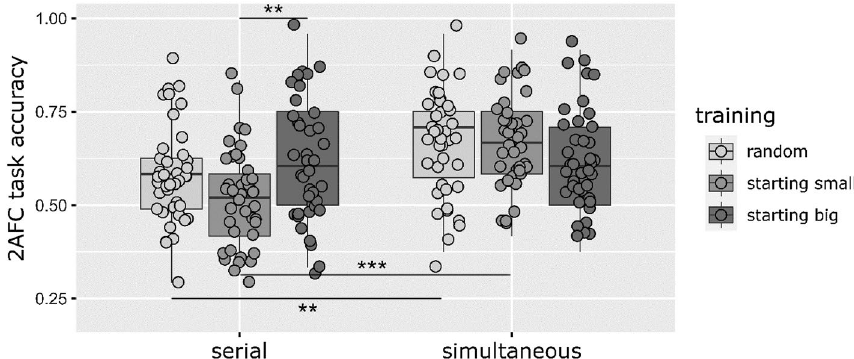
Figure 6. 2AFC accuracy in the Presentation*Training Type interaction in the case of visual stimuli. Dots represent the mean accuracies of individual participants in a given group (a small amount of jitter was added to increase visibility). Lines in boxes represent group medians, box lengths illustrate the group interquartile range, and whiskers show minimum and maximum values. Outliers are participant data which are outside the 1.5 interquartile range beyond the first and third quartiles. *: p < 0.05, **: p < 0.01, ***: p < 0.001. Serial starting small performance was lower than serial starting big performance, and simultaneous starting small performance; and simultaneous random performance was higher than serial random performance (regardless of